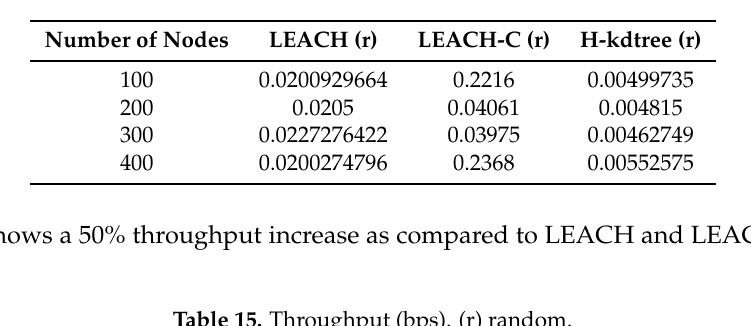
Table 14. Jitter (seg). (r) random.